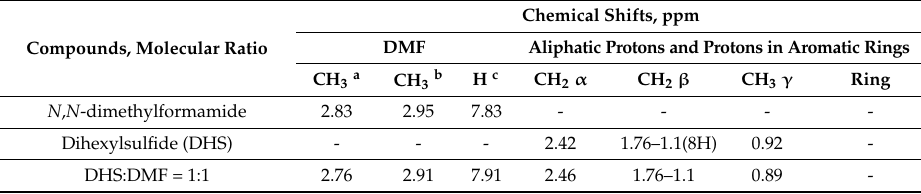
Table 2. Data of the PMR spectra of model compounds in carbon tetrachloride (0.2 mol/dm 3 ).